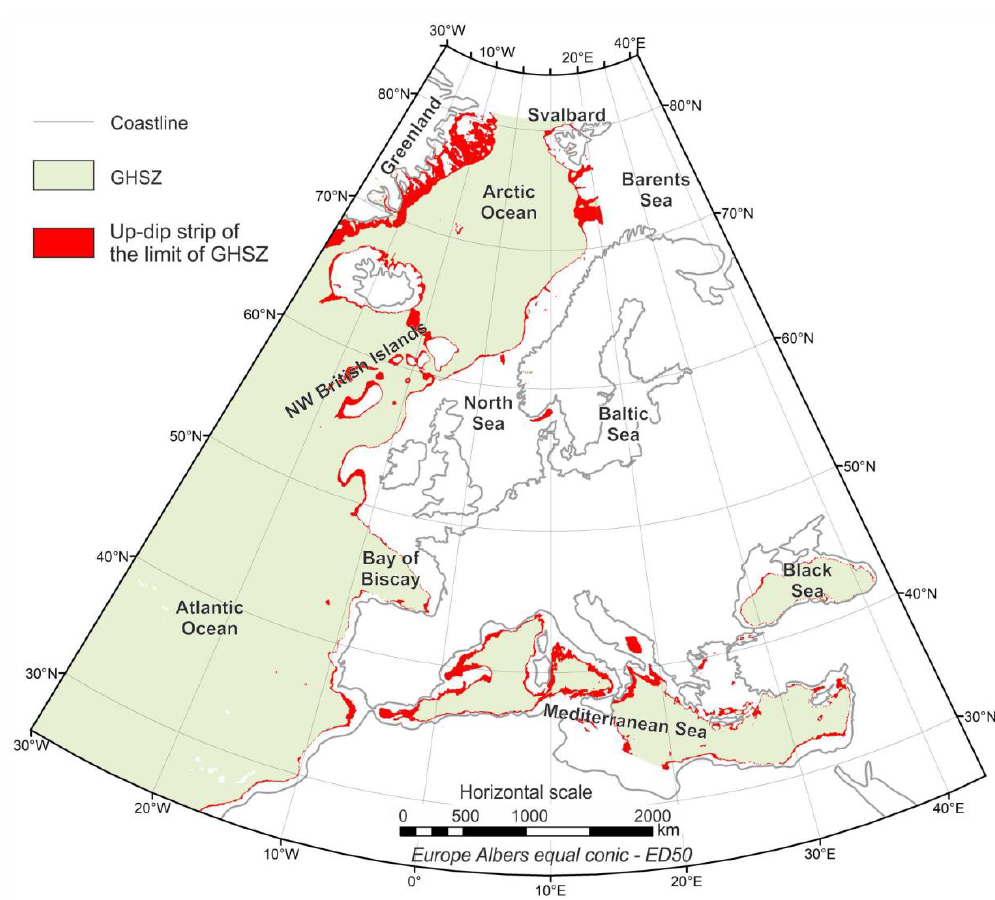
Figure 3. Theoretical up-dip limit of the GHSZ in the study area (modified from Núñez-Varela, 2020). In the volcanic area of Macaronesia (the Canary and Madeira islands), the up-dip limit has been eliminated because of the absence of hydrocarbon reservoirs on the flanks of the